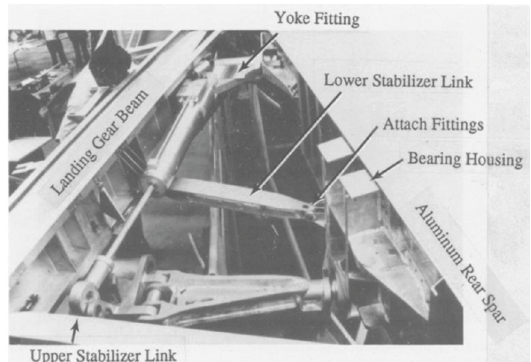
Figure 1. Titanium forging parts in the 757 landing gear structure. The landing gear beam is at the upper left 51